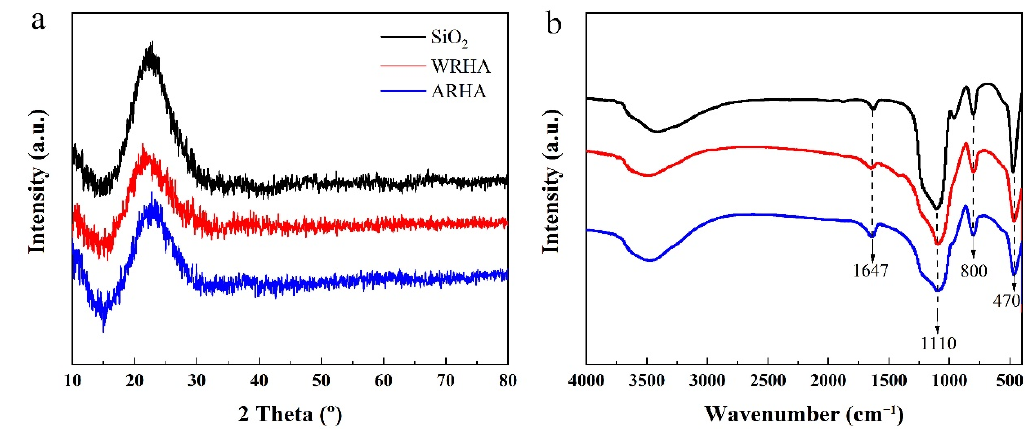
Figure 1. ( a ) XRD patterns and ( b ) FTIR spectra of the three kinds of fillers.